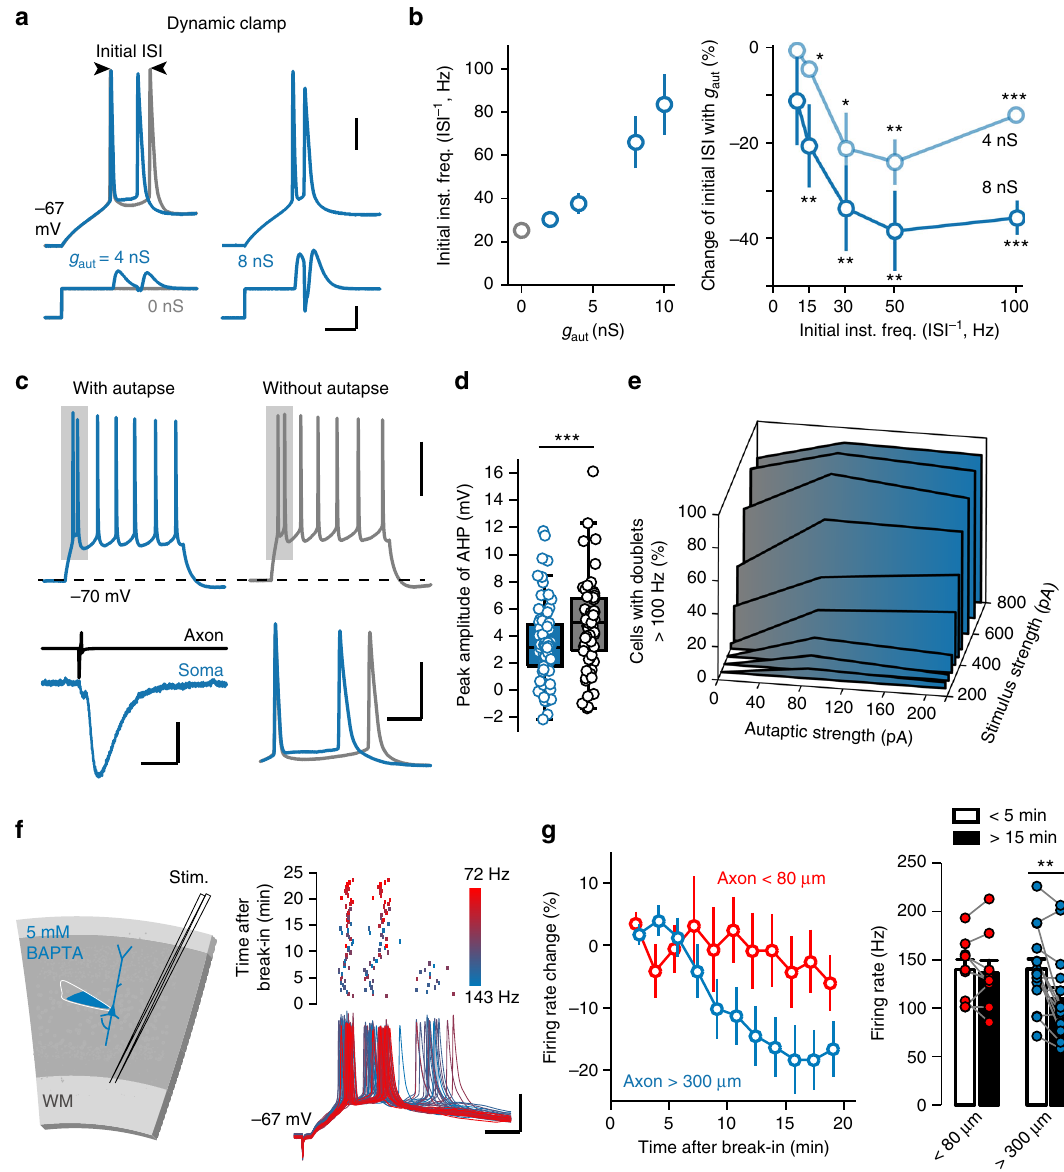
Fig. 6 PC autapses enhance burst fi ring. a A representative dynamic clamp recording. Autaptic conductances ( g aut ) were delivered to the recorded cell with a delay of 1.4 ms after each AP during step current injections. Note the shortening of the initial inter-spike interval (ISI) with the injection of 4-nS g aut and the burst fi ring with 8-nS g aut . Scale bars: 20 ms/200 pA for current and 20 mV for V m . b Left, plot of the initial instantaneous frequency as a function of g aut . Right, percentage of changes in initial ISI with 4-nS or 8-nS g aut at different frequencies (Wilcoxon rank-sum test and paired Student ’ s t -test). Data are represented as mean ± SEM. * P < 0.05; ** P < 0.01; *** P < 0.001. c Top, two representative voltage responses of PCs with and without autapses to step current injections (200 pA, 500 ms) (scale bar: 40 mV). Bottom, an evoked aEPSC in the autaptic PC (left, scale bars: 10 ms/100 pA) and an overlay of the initial two APs from the gray boxes (right, scale bars: 10 ms/40mV). d The average peak amplitude of AHP of PCs with and without autapses (Wilcoxon rank-sum test). Boxplots represent the median and interquartile range and whiskers represent 1.5× interquartile range. *** P < 0.001. e Plot of the percentage of cells with initial doublets higher than 100 Hz as a function of autaptic strength and stimulus strength. f Left, schematic of recording from a layer-5 PC with BAPTA-containing pipette solution while stimulating the slice at the border of layer VI and white matter (WM). Right, a representative recording from a PC (length of the axon trunk > 300 μ m) showing a progressive reduction in intra-burst frequency with BAPTA infusion. Scale bars: 10 ms/ 40 mV. g Left, percentage of changes in fi ring rate in PCs with different axon-trunk lengths (<80 μ m and >300 μ m). Right, comparison of the fi ring rates within the initial 5 min and those 15 min later. Data are represented as mean ± SEM. ** P < 0.01, paired Student ’ s t -test